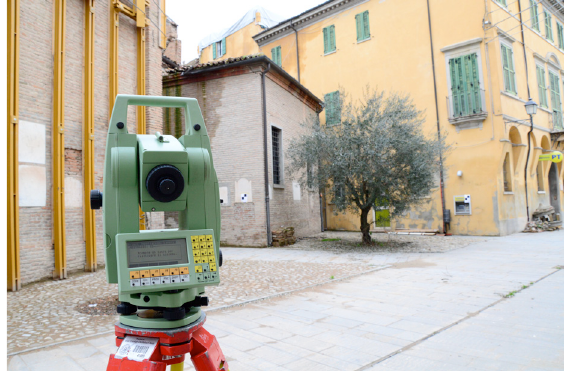
Figure 5: Total station TCR Leica